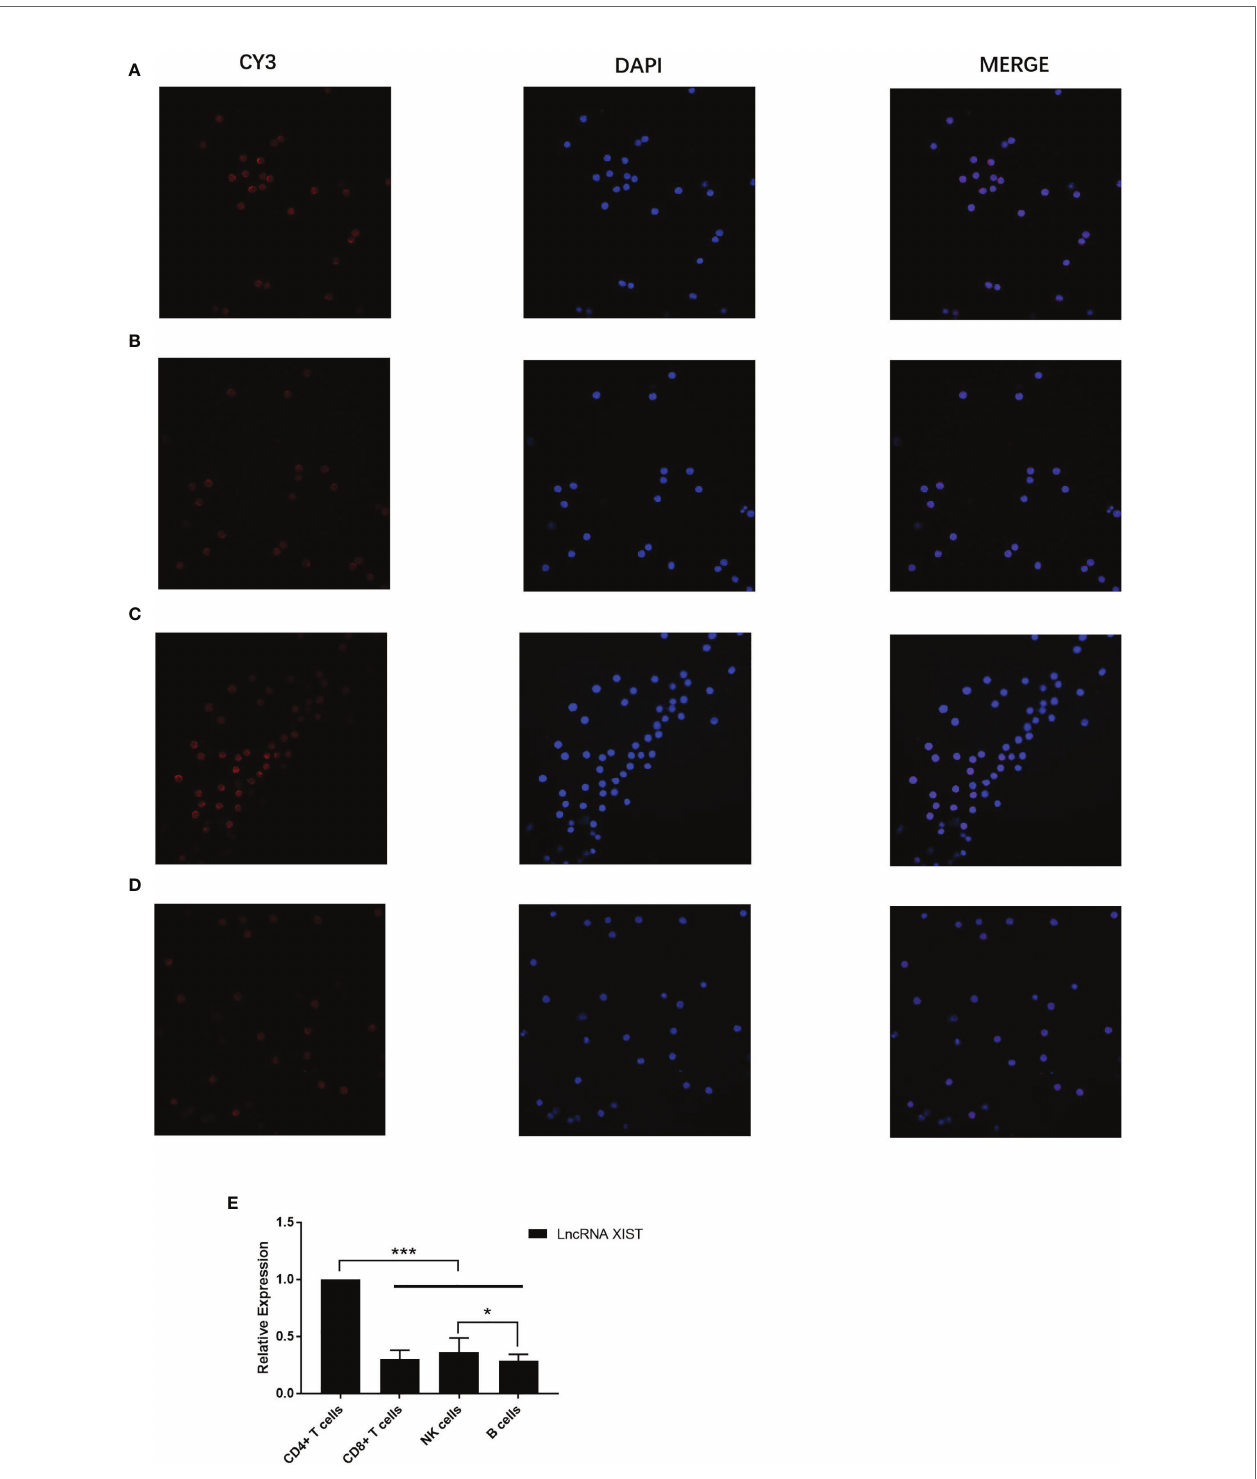
FIGURE 2 | The localization of LncRNA XIST in immune cells of PBC patients were different. Representative images (confocal laser scanning microscope) and the subcellular localization of lncRNA XIST in the immune cells was identi fi ed. Red: CY3 labeled LncRNA XIST, blue: DAPI staining. Localization of LncRNA XIST in CD4+ T cells (A) , CD8+ T cells (B) , NK cells (C) , B cells (D) of PBC patients (n=20) were different. (E) Relative expression of LncRNA XIST in CD4+ T cells, CD8+ T cells, NK cells, B cells. The data are presented as mean±SEM of three independent experiments (*p < 0.05; ***p <